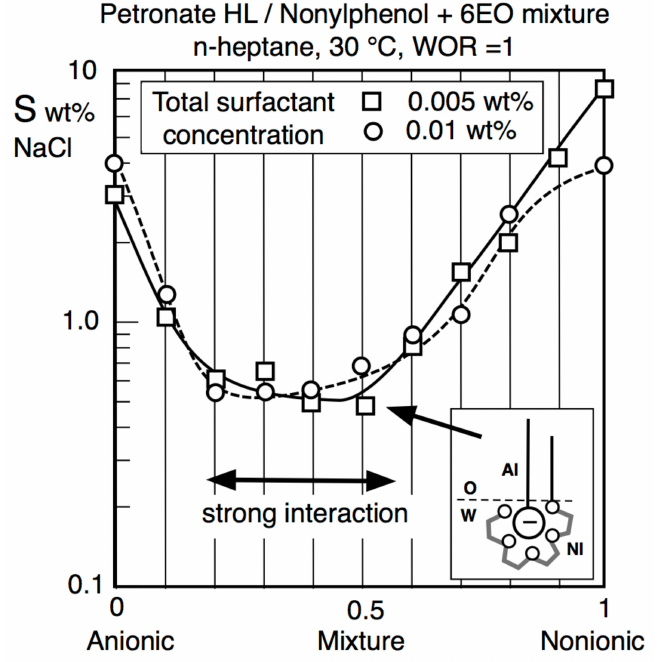
Figure 20. Salinity scan for mixtures of anionic and nonionic surfactants at very low